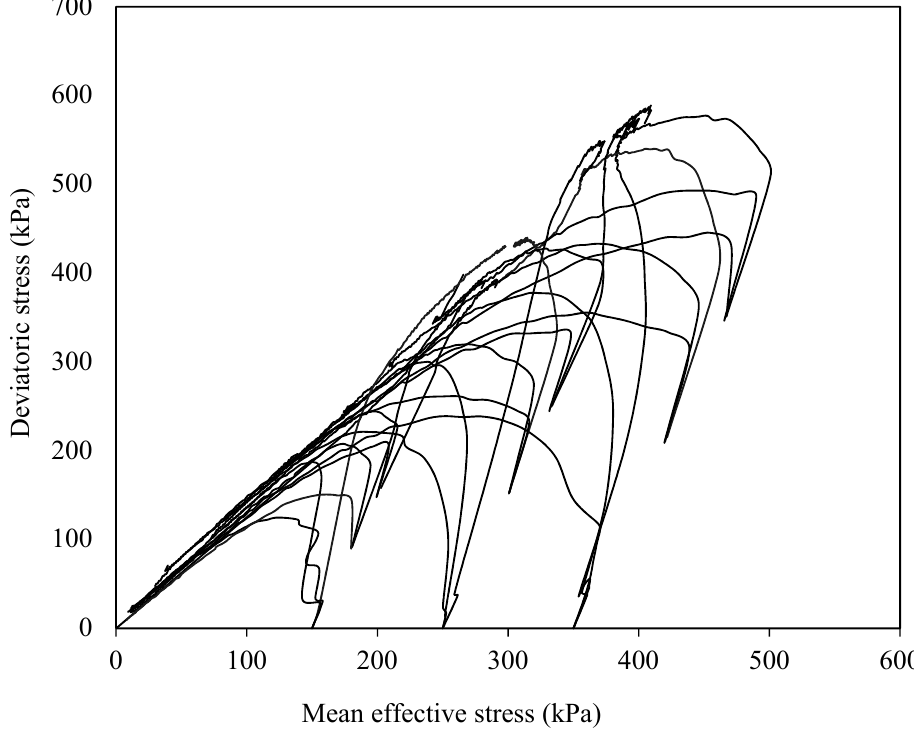
Figure 7. Steady state line in q–p’ plane with all 27 stress paths.